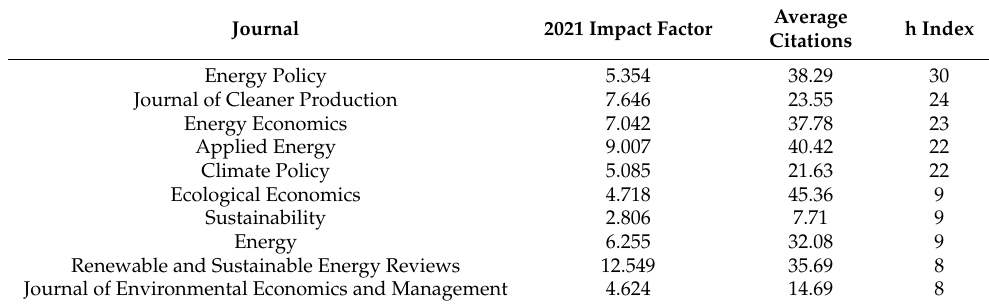
Table 2. Journal distribution.